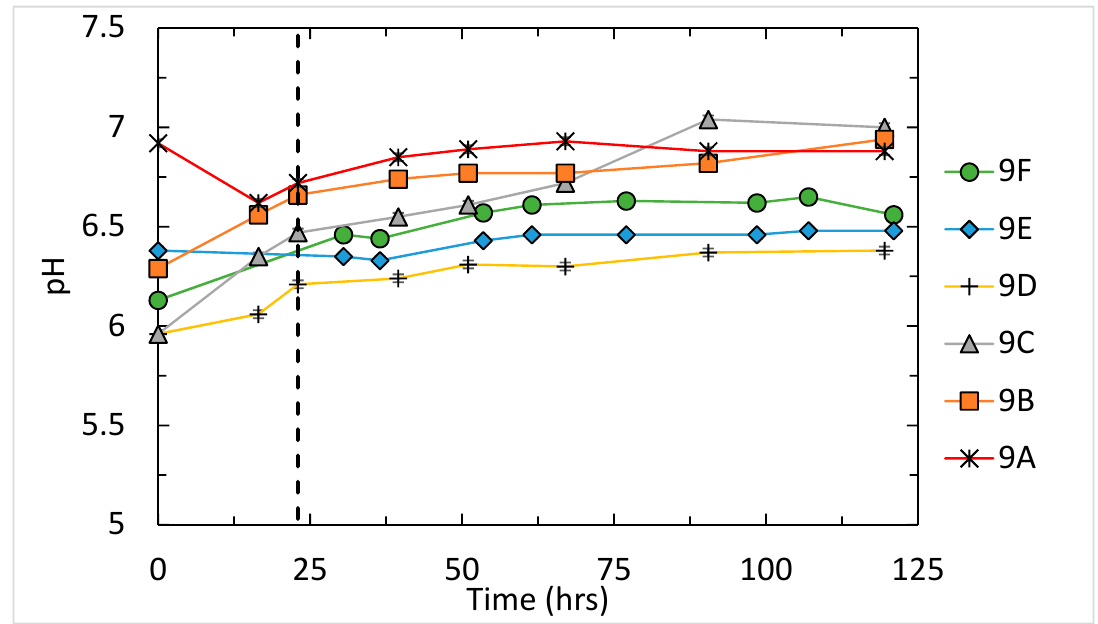
Figure 2. Graphical representation of pH plotted against time for experiments 9A through 9F. The analytical uncertainty was ± 0.02, and is included in the symbol size. The vertical dashed line indicates the observed onset of crystallization at approximately 24 h.